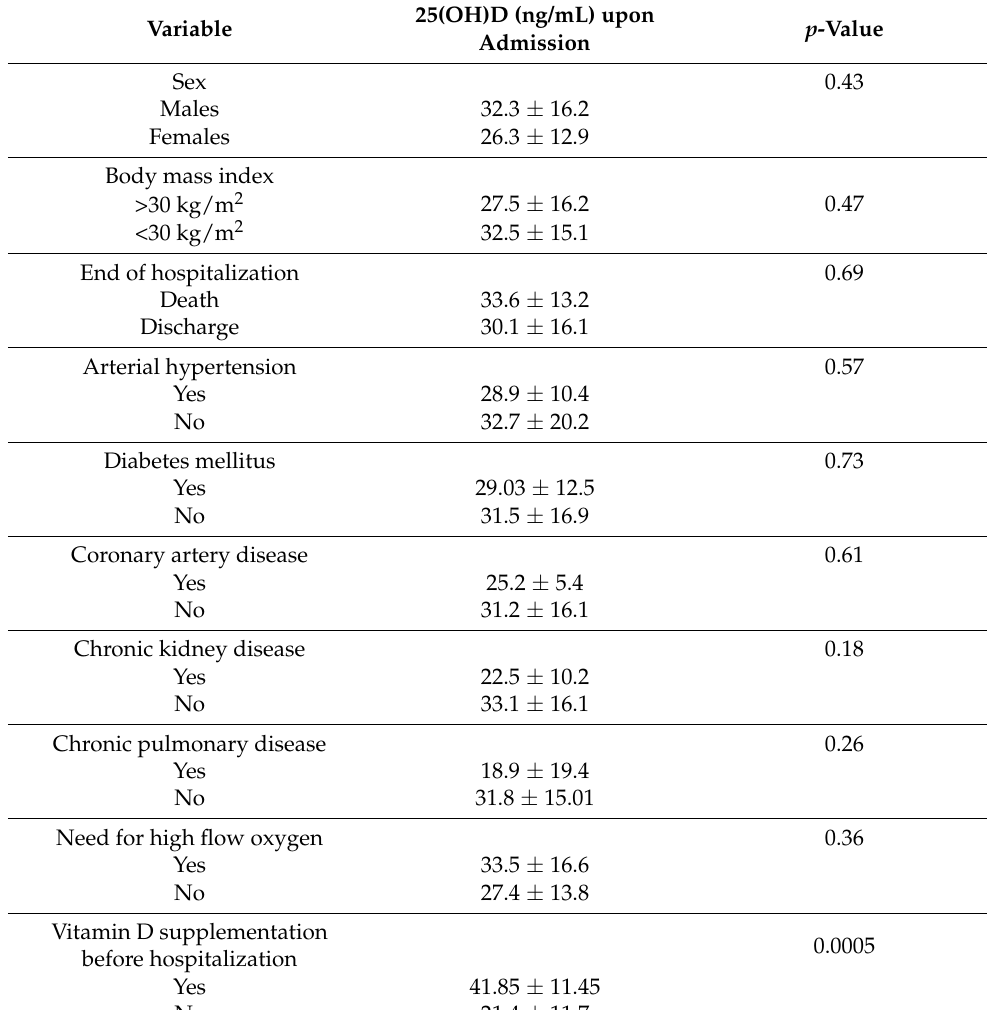
Table 2. The difference in 25-hydroxyvitamin D (25[OH]D) concentration between selected subgroups of patients upon